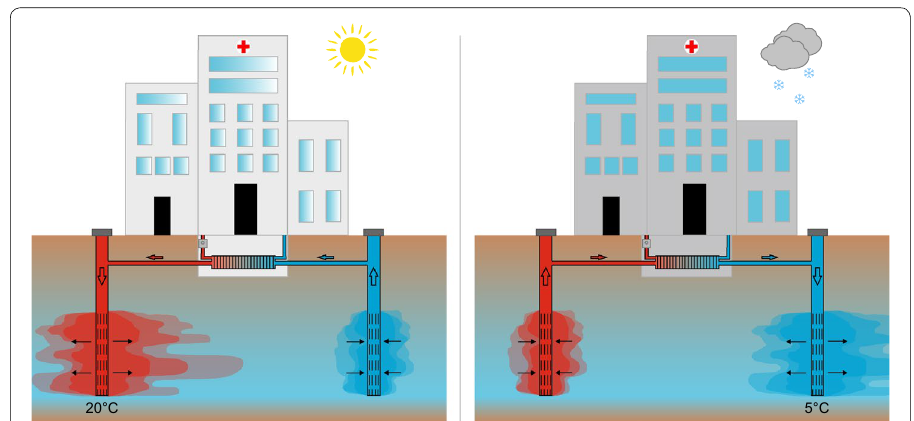
Fig. 1 Operation mode of a doublet ATES system in summer and wintertime including the current temperature threshold for LT-ATES in